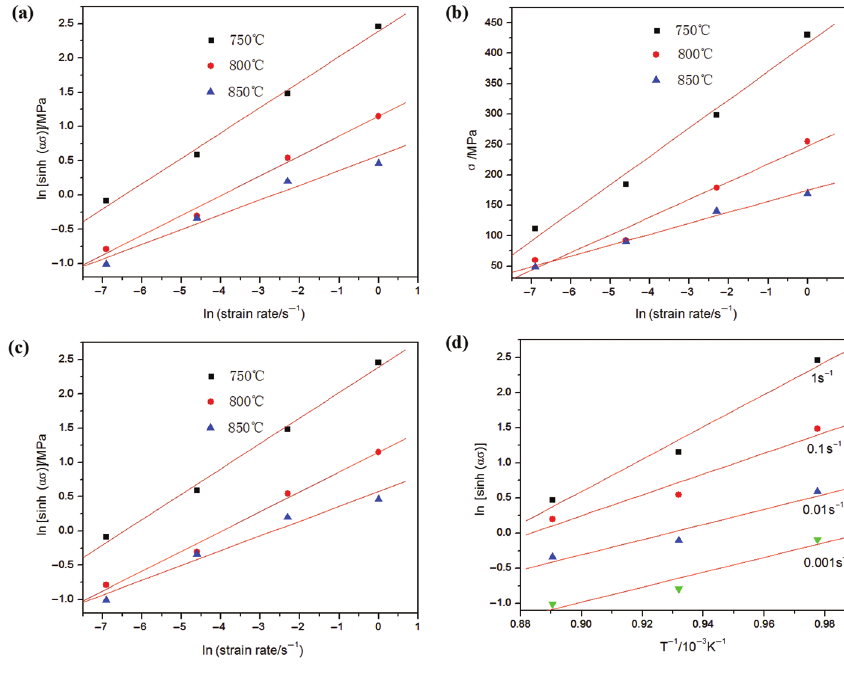
Figure 6: Relationship between (a) ln σ and ln _ ε ; (b) σ and ln _ ε ; (c) ln[sinh